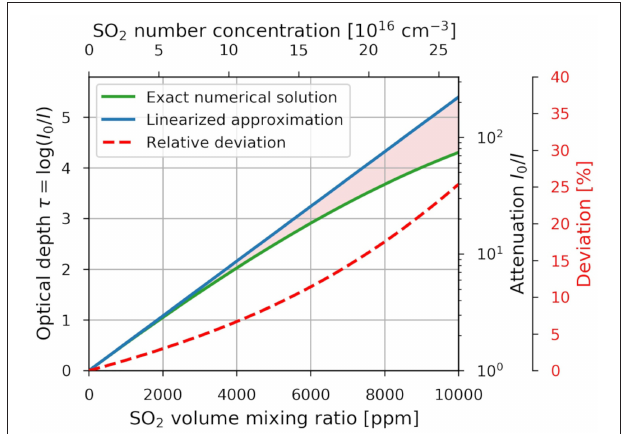
FIGURE 2 | Calculated response curves of the PITSA to SO 2 number concentration/volume mixing ratio expressed in observed optical depth/light attenuation. Shown are the curves for the exact numerical calculation and the linearized approach (Equation 6). For the relative deviation between them (red dashed line) the third y-axis on the right applies.